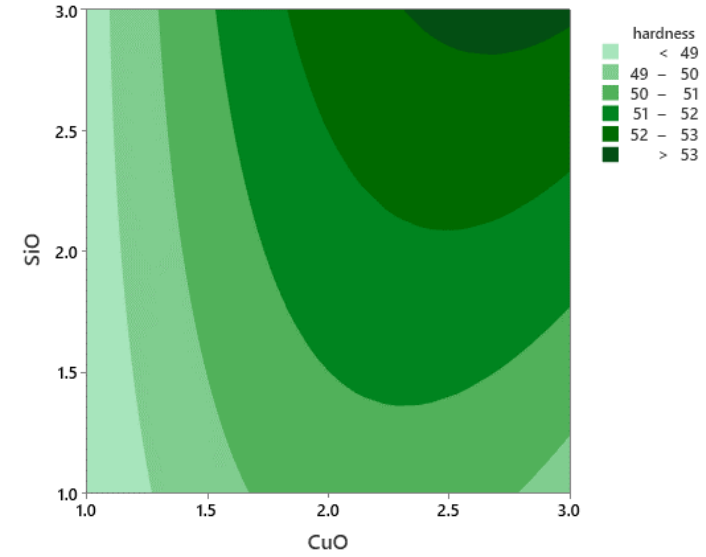
Figure 12. Contour plot for microhardness. The equation indicates that the PHT has a significant effect on the